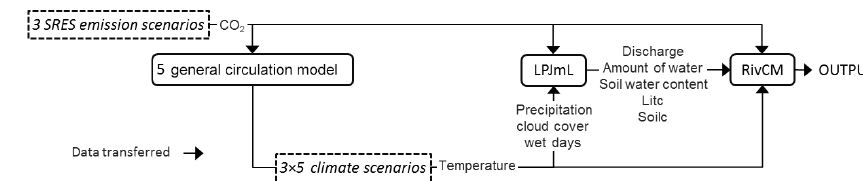
Figure 1. Overview of the transfer of data between the models and